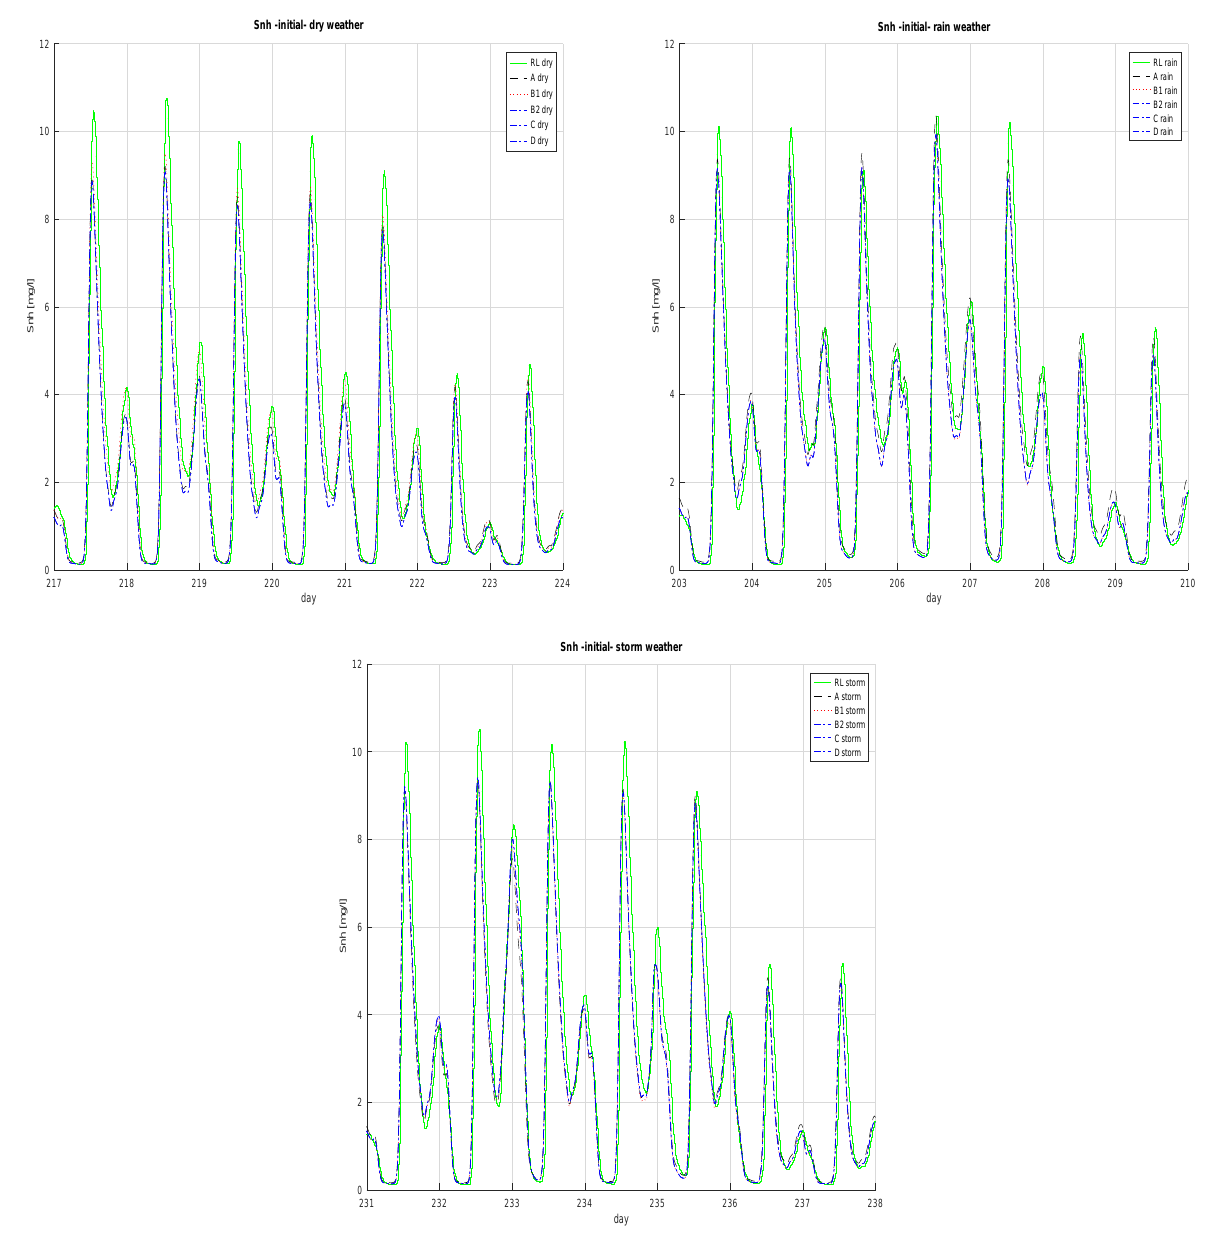
Figure 11. S NH concentration for the initial